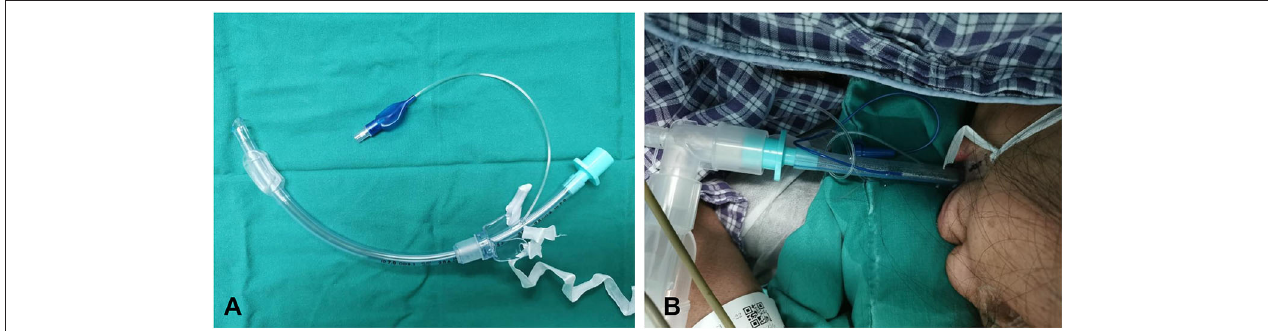
FIGURE 1 | The prone position tube. (A) The prone position tube is designed as a whole unit with a fixture that is affixed to the tube to increase the stabilization. (B) The prone position tube was applied for a patient undergoing prone position